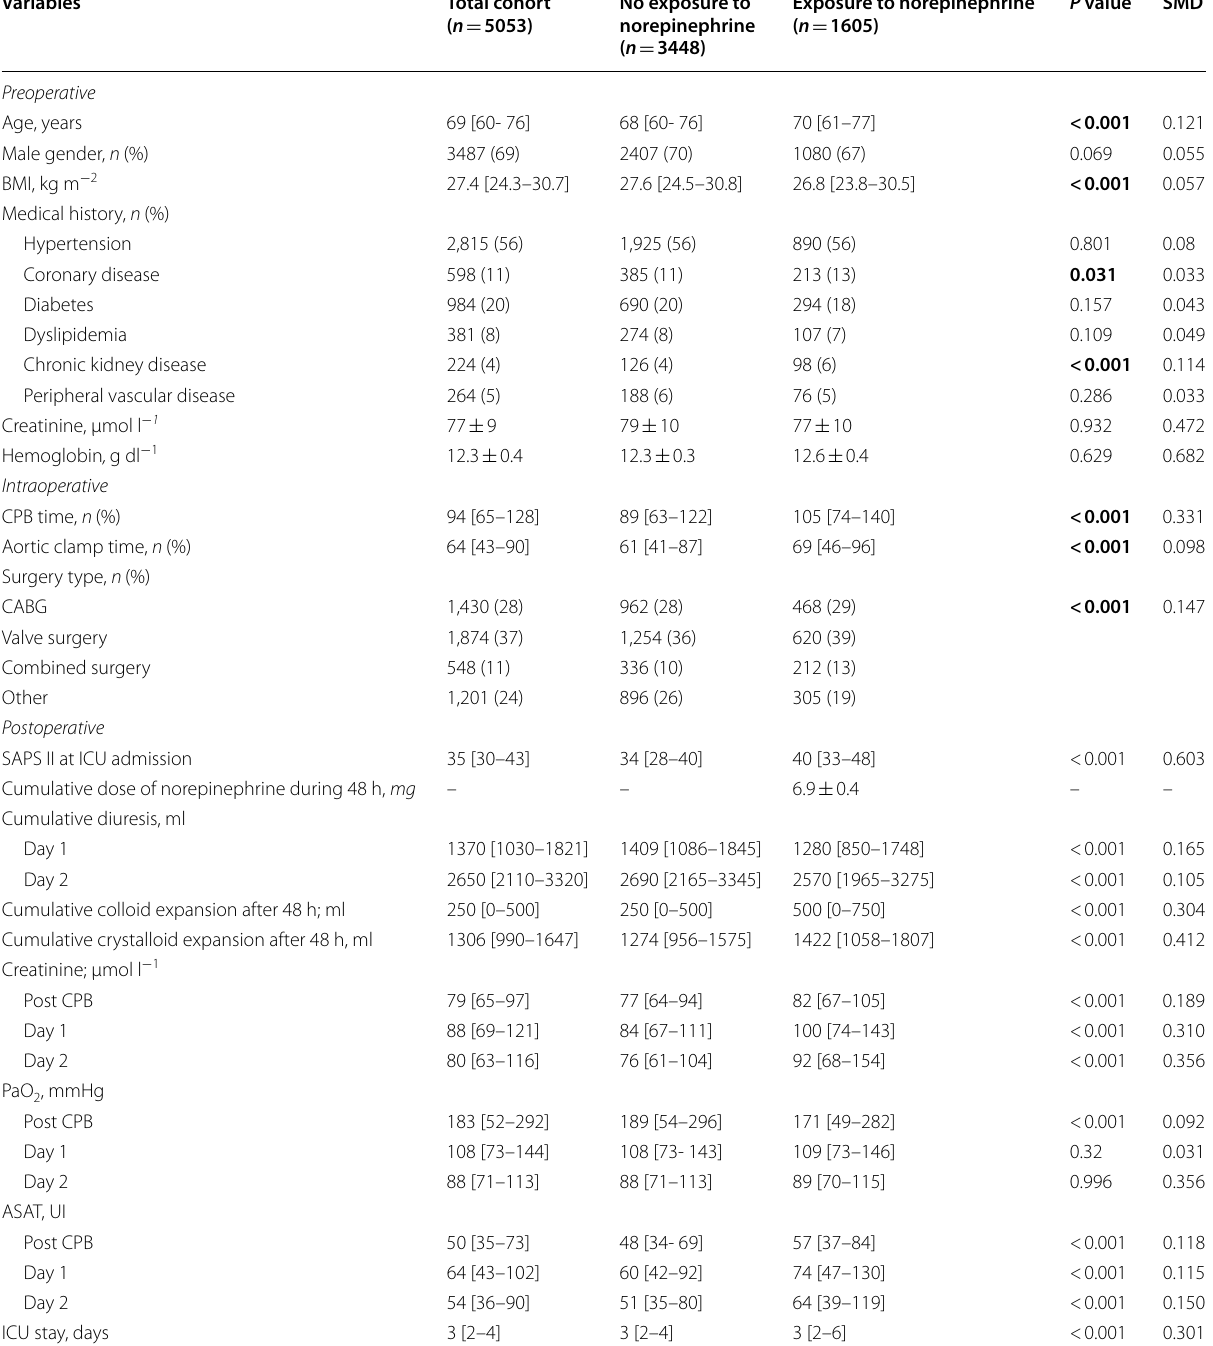
Table 1 Patient characteristics of the